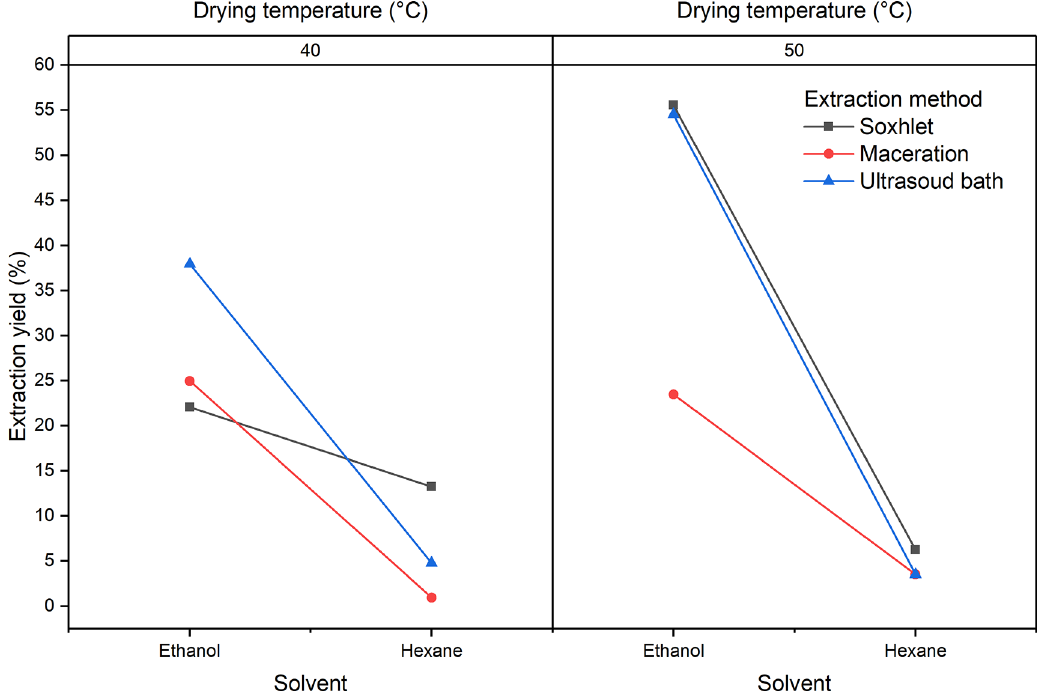
Figure 2. ANOVA graph for the influence of factors on the extraction performance of Bidens pilosa